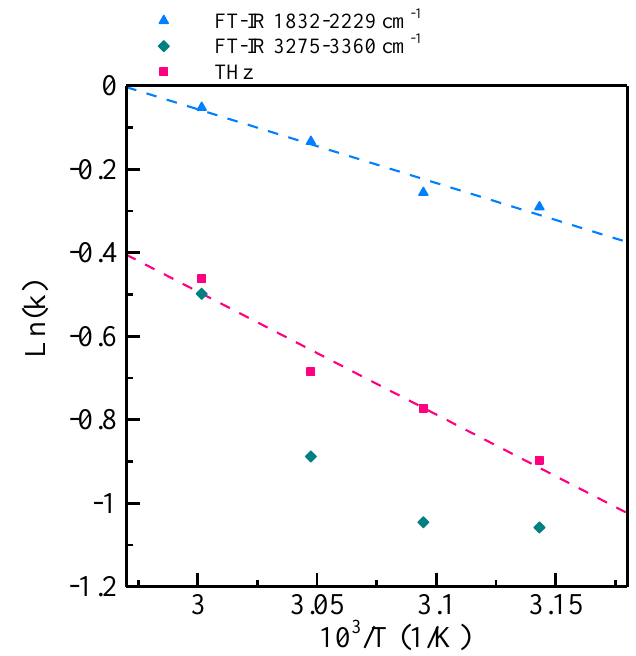
Figure 8. Arrhenius plots of samples stored in a 51.12 ± 3.5 g/m 3 water vapour atmosphere. Blue triangles and green diamonds represent FT-IR data, and pink squares represent THz data. The value of k corresponds to the reaction rate calculated by MCR-ALS analysis.